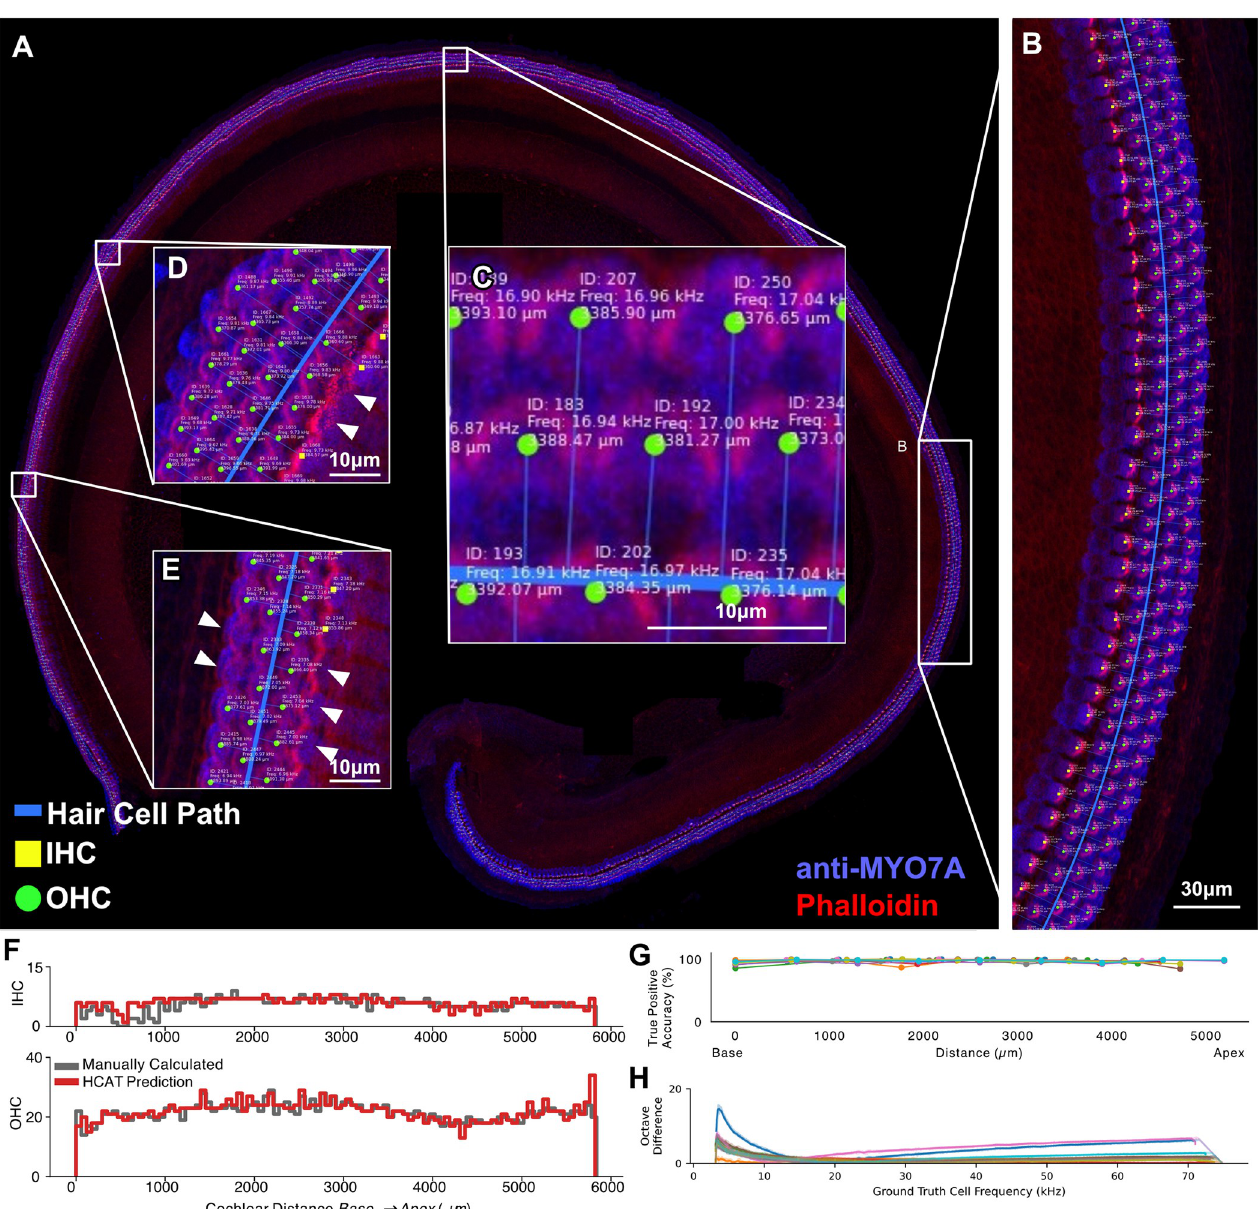
Fig 4. Validation output of early postnatal wild-type mouse hair cell detection analysis. A validation output image is generated for each detection analysis performed by the software. An image is automatically generated by the software similar to the one shown here for a dataset that includes an entire cochlea ( A ), with the vast majority of cells accurately detected ( B ). For each image, the model embeds information on cell’s ID, its location along the cochlear coil (distance in μ m from the apex), its best frequency, cell classification (IHC as yellow squares, OHC as green circles), and the line that represents tool’s cochlear path estimation (( C ), blue line). The very few examples of poor performance are highlighted in ( D ) and ( E ) (arrowheads point to three missed IHCs and two OHCs). A set of cochleograms reporting cell counts per every 1% of total cochlear length, generated with manual cell counts and frequency assignment (gray) closely agrees with an HCAT-predicted cochleogram (red) generated in a fully automated fashion ( F ). HCAT is accurate along the entire length of the cochlea ( G ), as evident by assessing the accuracy with a bin size of 10% of cochlear length. To assess the accuracy of the tool’s best frequency assignment, the magnitude difference between every cell’s best frequency calculated manually, and automatically, with respect to frequency for eight different cochleae is at maximum 15% of an octave across all frequencies ( H ). Each color represents one cochlea. HCAT, hair cell analysis toolbox; IHC, inner hair cell; OHC, outer hair cell.